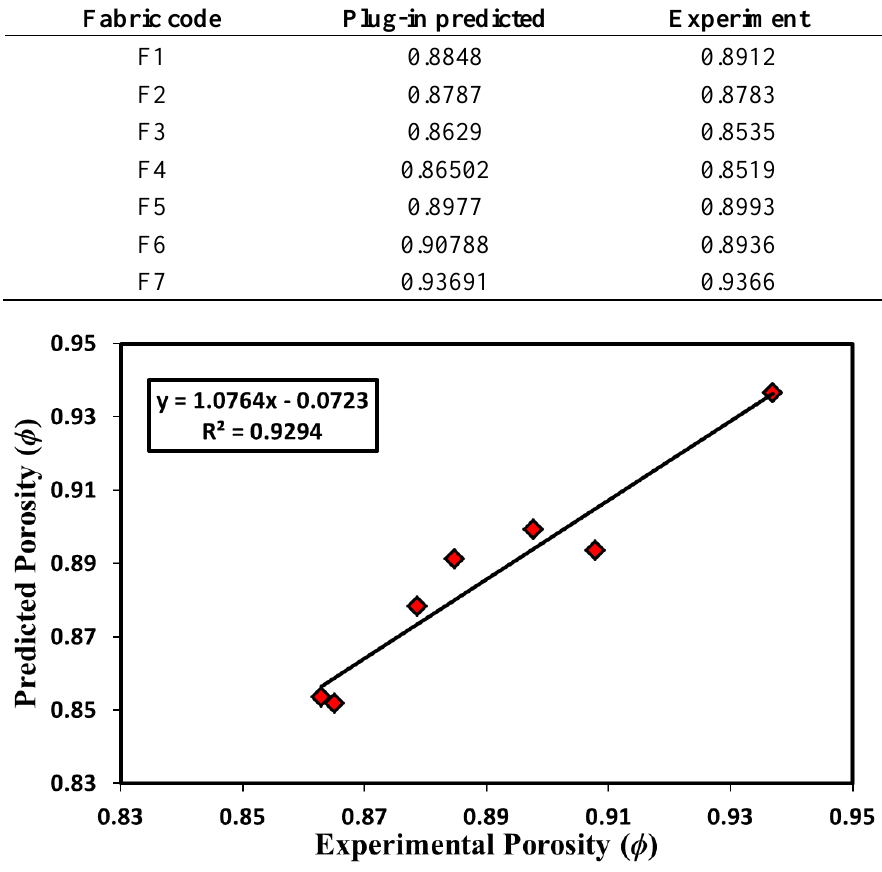
Figure 8. Comparison of porosity between plug-in predicted and